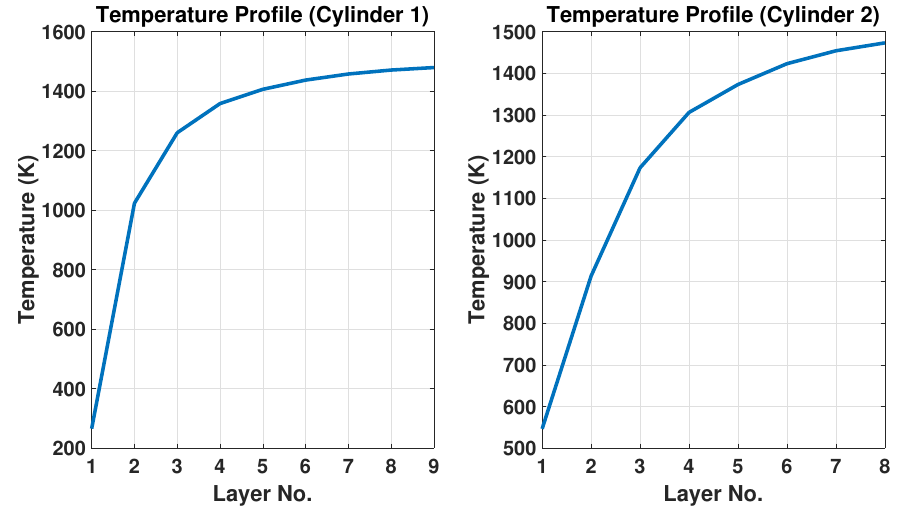
Figure 8. Temperature profile of cylinder 1 and cylinder